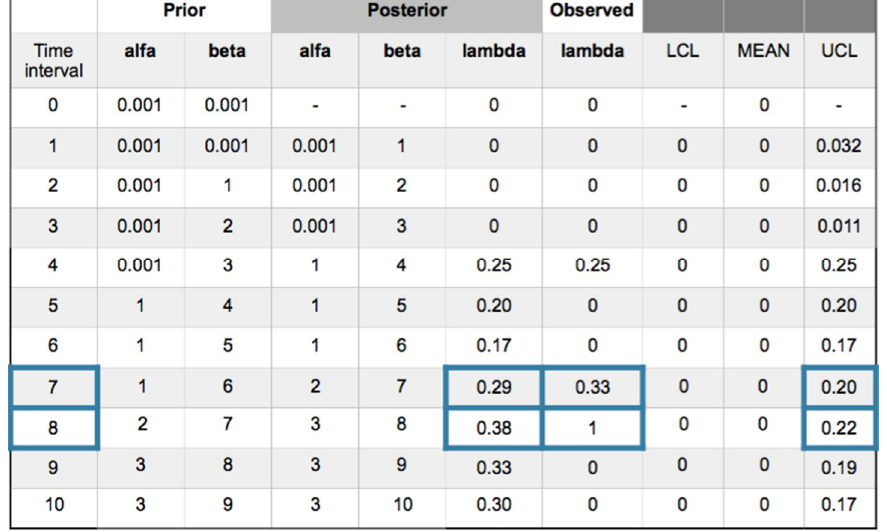
Figure 14. Poisson–gamma model. Recurrent with mean prior method. Evolution of collected (ic’s) and safety barrier fails in 10